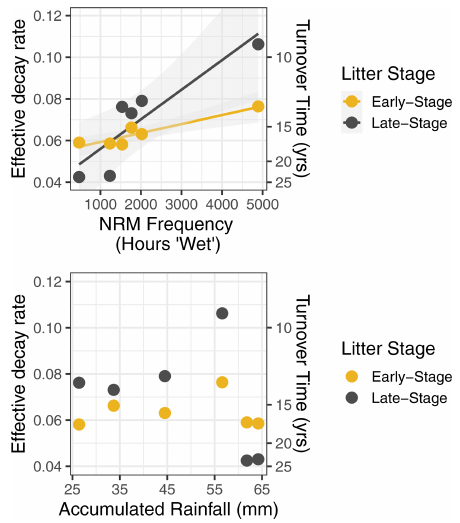
Figure 4. Effective decay rate calculated without explicit temper- ature or NRM sensitivity (Eq. 1) relative to NRM frequency and accumulated rainfall during the study period. Among sites, de- cay rate constant was strongly correlated with the proportion of time that a site experienced NRM conditions (early-stage: R 2 = 0 . 87, P = 0 . 007, slope = 4 . 311 × 10 − 6 ; late-stage: R 2 = 0 . 80, P = 0 . 02, slope = 1 . 421 × 10 − 5 ) but was uncorrelated with total rain- fall (early-stage: R 2 = 0 . 01, P = 0 . 87; late-stage: R 2 = 0 . 14, P = 0 .